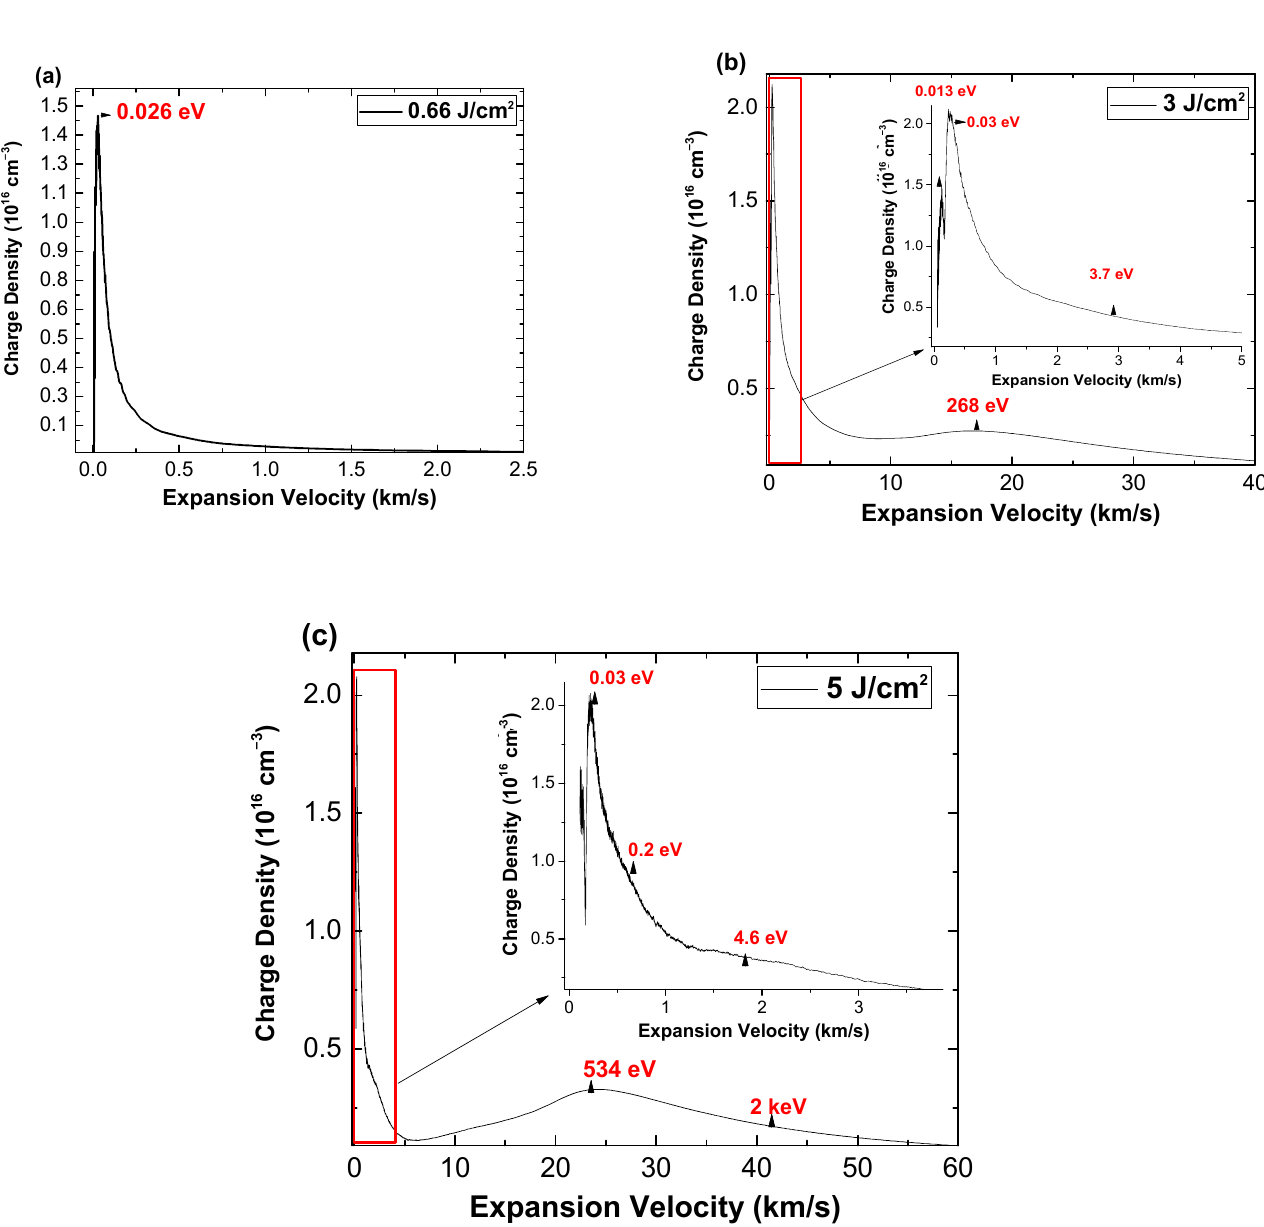
Figure 6. HfO 2 plasma charge density distribution with expansion velocity characterizing different irradiation conditions (0.66 J/cm 2 ( a ); 3 J/cm 2 ( b ) and 5 J/cm 2 ( c )).